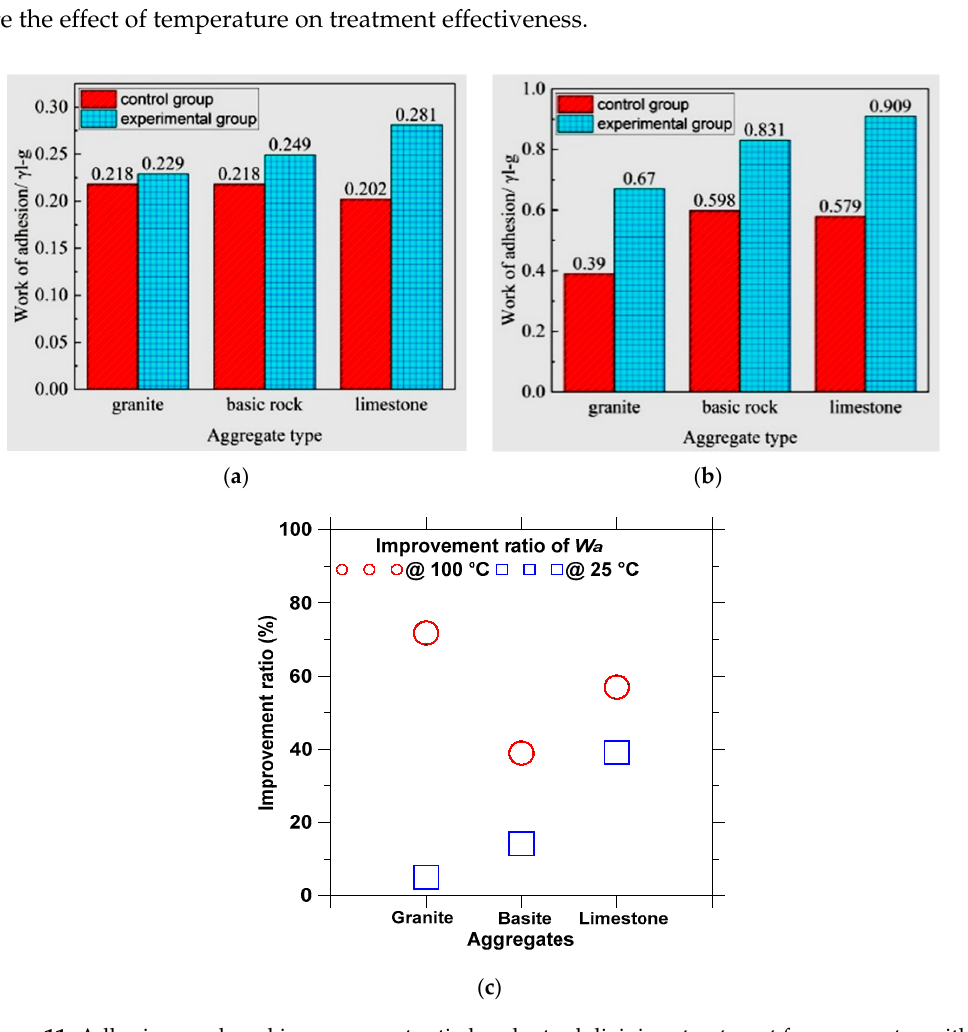
Figure 11. Adhesion work and improvement ratio by plant ash lixivium treatment for aggregates with #90 asphalt: ( a ) W a at 25 °C; ( b ) W a at 100 °C; and ( c ) improvement ratio.